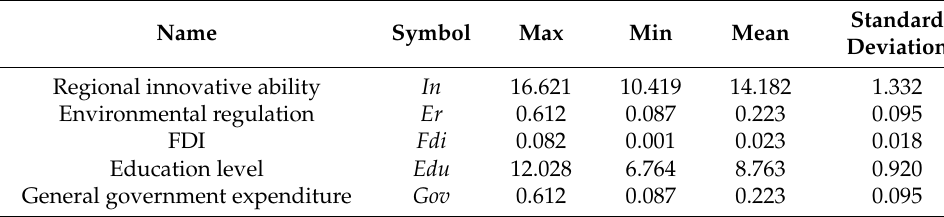
Table 2. Descriptive statistics of variables.